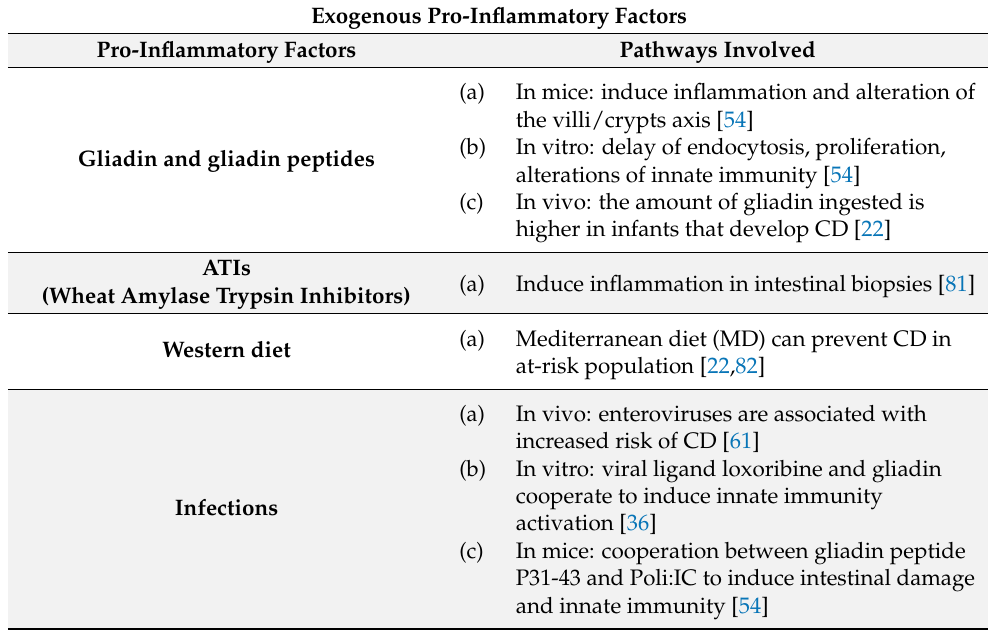
Table 2. Exogenous environmental factors can activate pro-inflammatory pathways in vivo and in vitro in CD cells. CD: celiac disease; Poli:IC: polyinosinic:polycytidylic